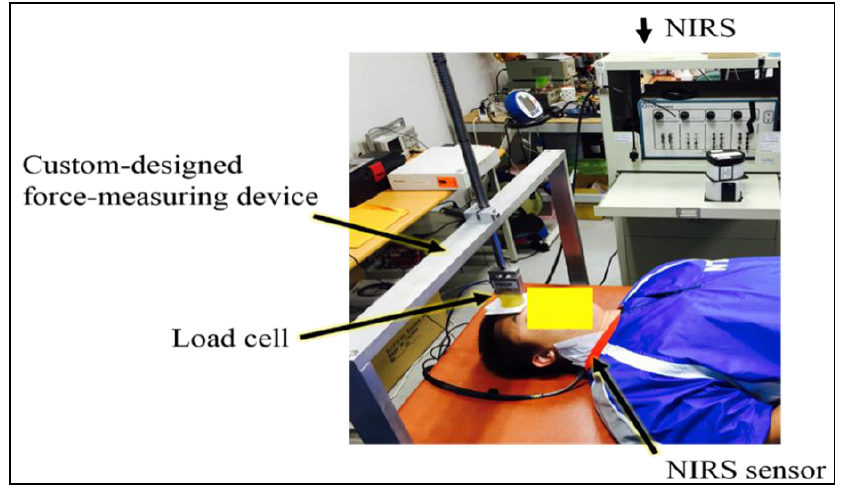
Figure 1. Experimental set-up for collecting muscular oxygenation variables of the dominant or affected sternocleidomastoid muscles by means of commercial NIRS system (Imagent, ISS Inc., Champaign, IL, USA) in real-time at a 25 Hz sample rate during isometric flexion.